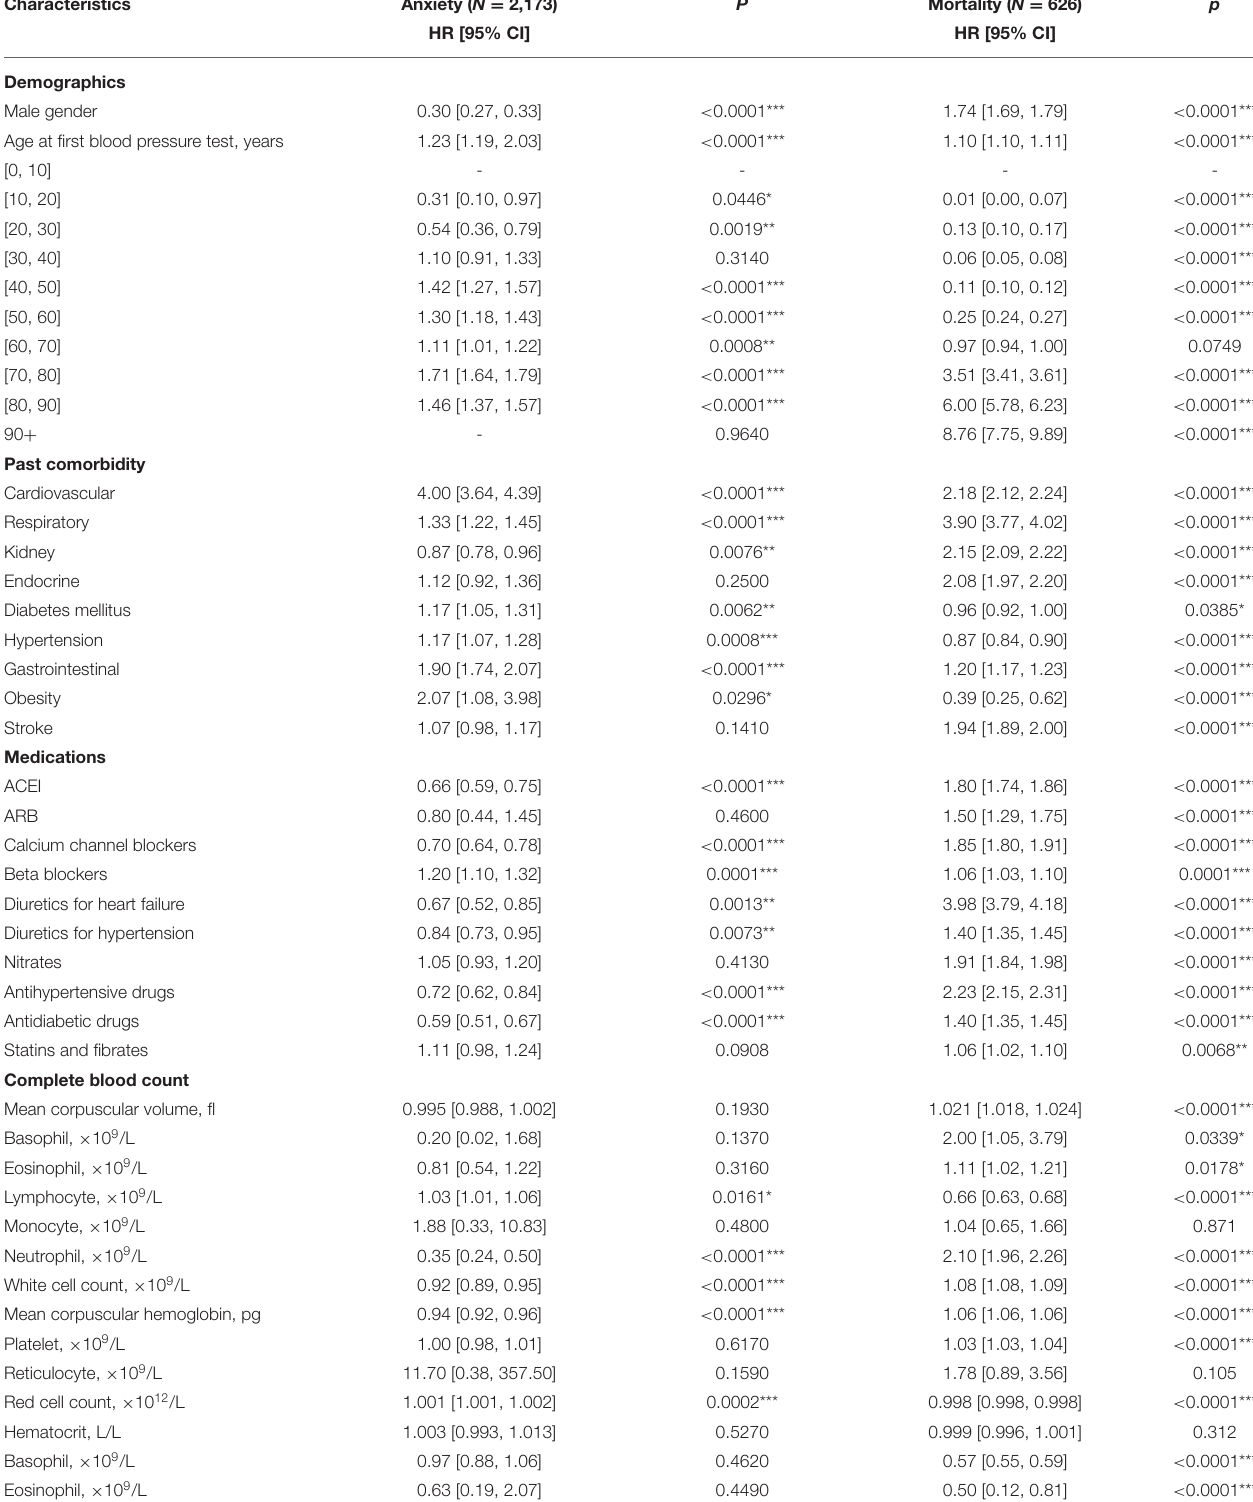
TABLE 2 | Univariate Cox analysis to predict incident anxiety and mortality.